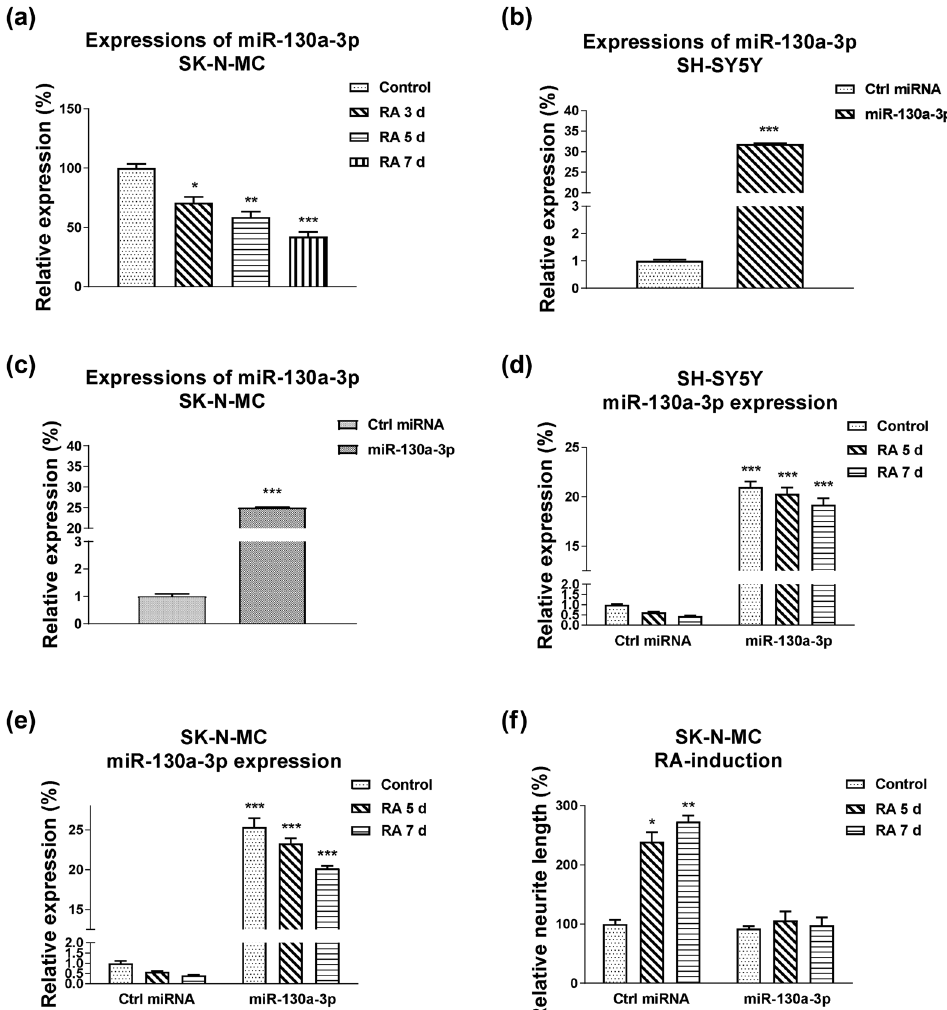
Figure S3: miR - 130a - 3p suppresses RA - induced neuron di ff erentiation. ( a ) Expressions of miR - 130a - 3p in SK - N - MC cells under RA treat - ments at 3, 5 and 7 days were determined by qRT - PCR. ( b ) E ff ects of miR - 130a - 3p overexpression in SH - SY5Y and ( c ) SK - N - MC cells. ( d ) Detection of miR - 130a - 3p expressions in SH - SY5Y and ( e ) SK - N - MC cells without or with miR - 130a - 3p overexpression under RA treatments for 5 and 7 days. ( f ) The relative neurite length was calculated in SK - N - MC cells without or with miR - 130a - 3p overexpression under RA treatments for 5 and 7 days. *, p < 0.05; **, p < 0.01; ***, p < 0.001.